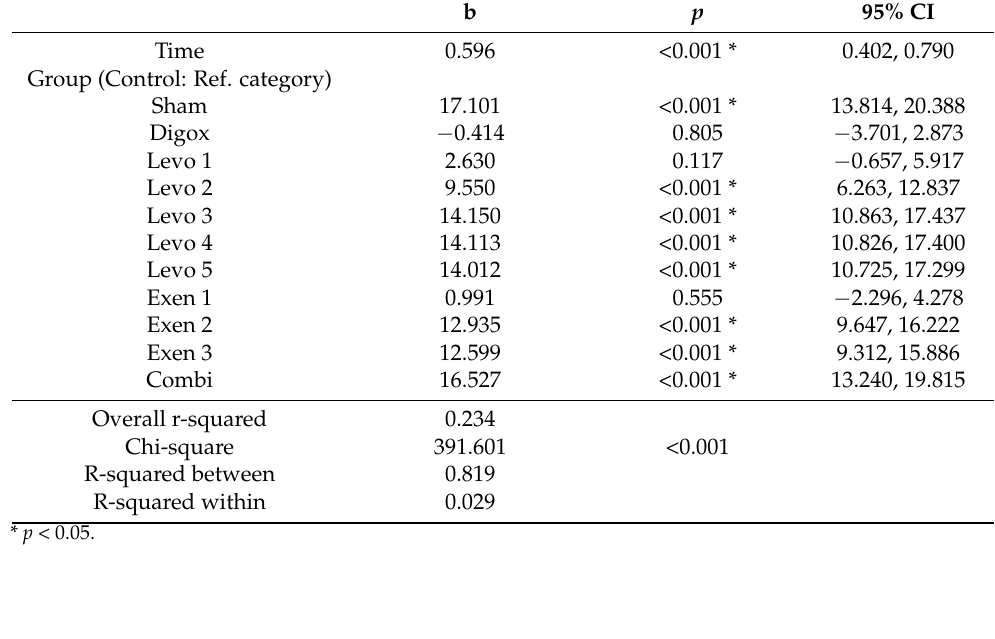
Table 1. Longitudinal analysis for LVSP for all groups.